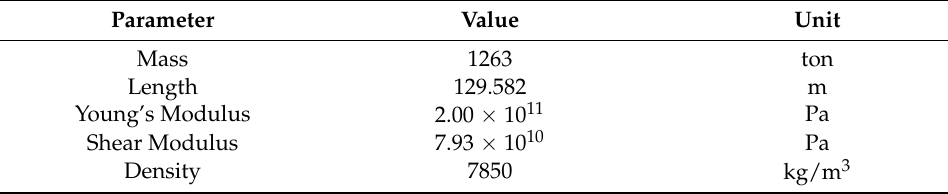
Table 3. Floating-Tower Geometric Properties.